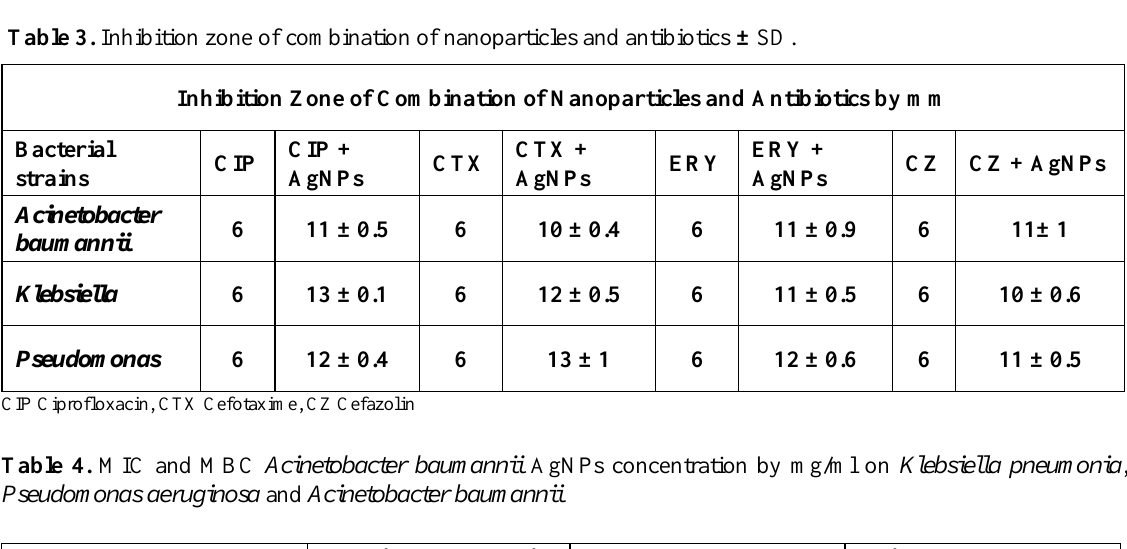
Table 3. Inhibition zone of combination of nanoparticles and antibiotics ± SD.